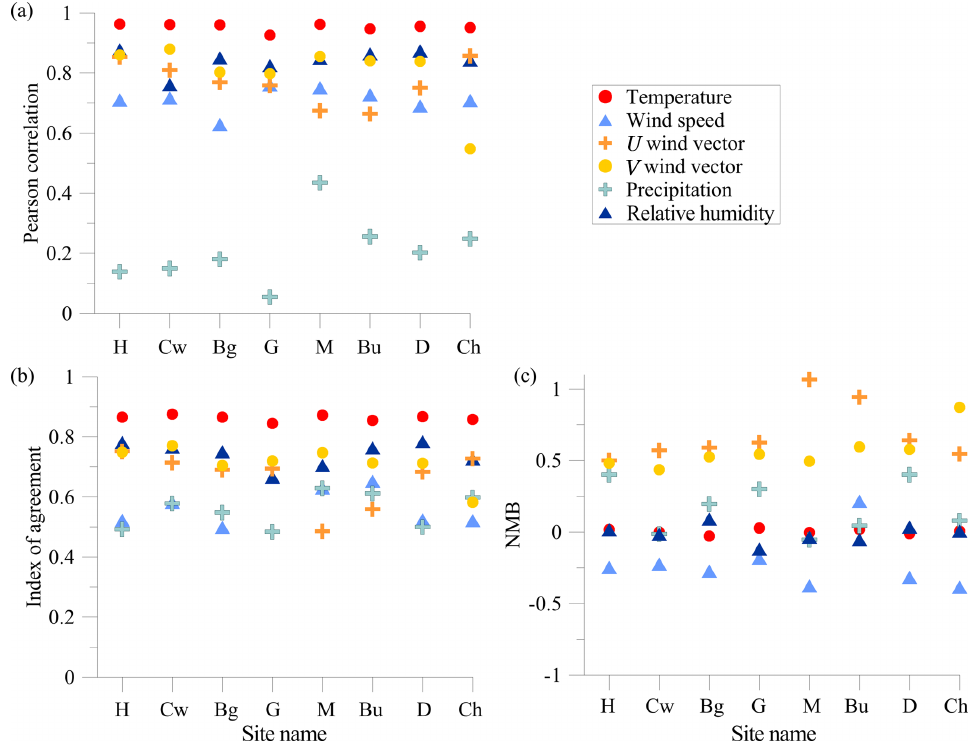
Figure 5. Comparison of observed and modelled meteorological variables at automatic weather station sites nearest to the pollen observation sites. (a) Pearson correlation. (b) Index of agreement. (c) Normalised mean bias.